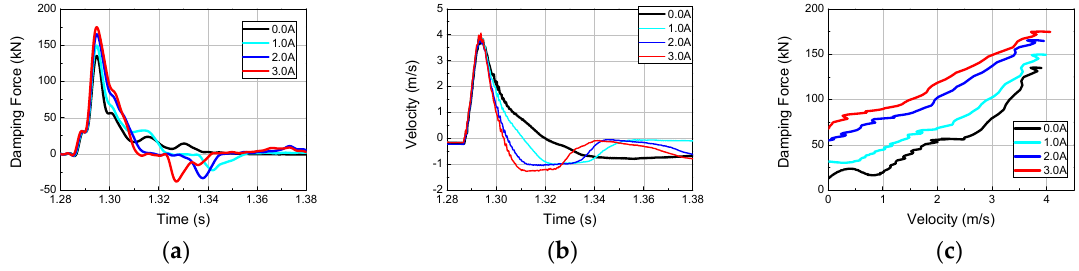
Figure 8. MR damper experimental results at an impact velocity of 7.75 m/s (Test 3): ( a ) Damping force Piston velocity; ( b ) Piston Velocity; ( c ) F-V diagram of MR damper.